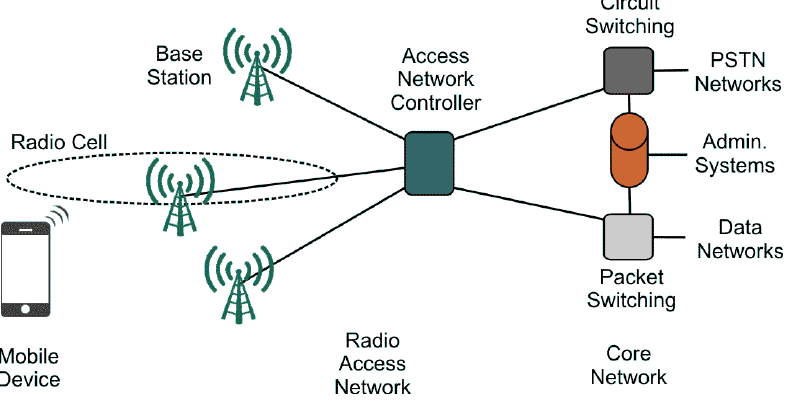
Figure 1. A general architecture for cellular